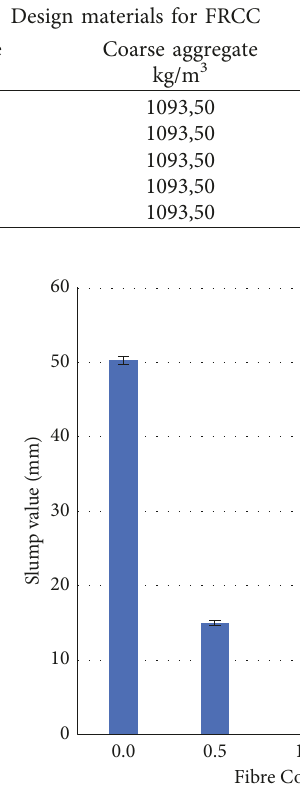
Figure 1: Showing slump values with PET fibre in